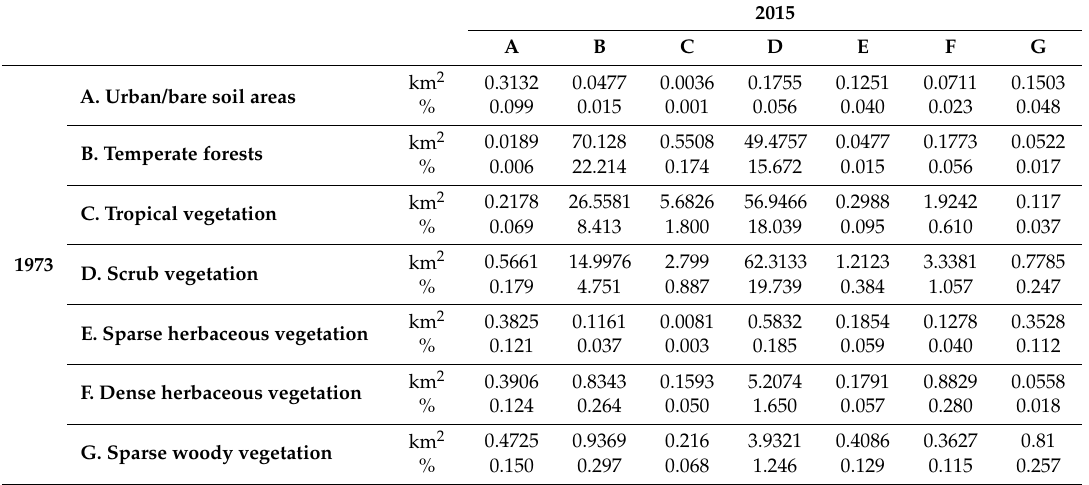
Table 17. Matrix of land use-cover changes from 1973 to 2015, in Natural Protected Area Altas Cumbres (NPAAC). Victoria, Tamaulipas,